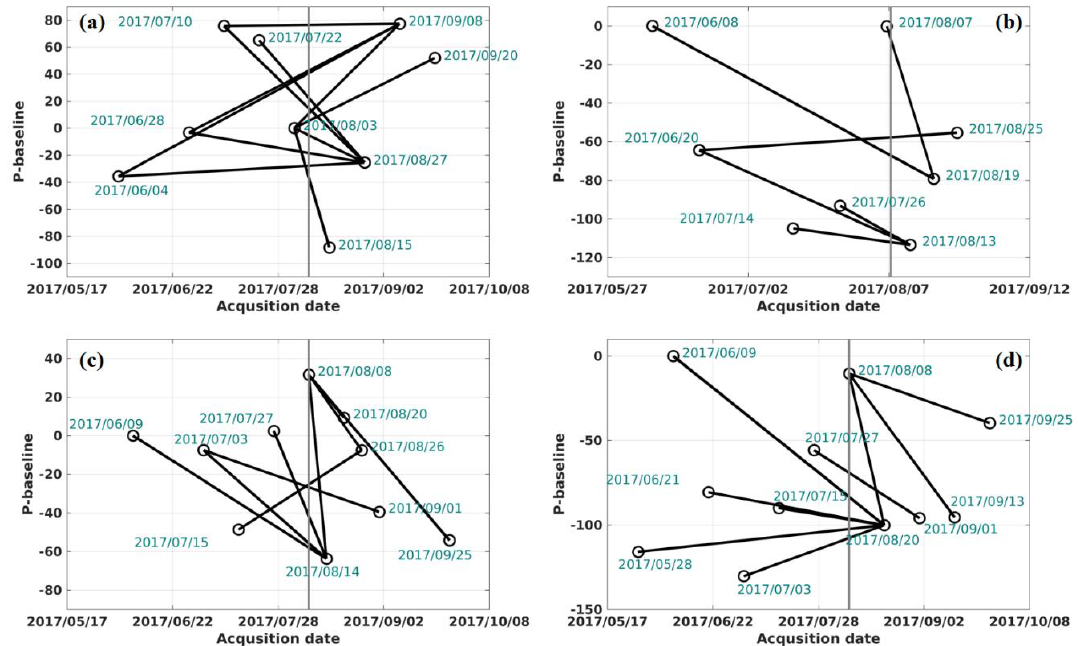
Figure 3. Baseline information for four tracks with different viewing geometries; the y-axis denotes the B ⊥ (P-baseline); and x-axis denotes the acquisition dates formatted as yyyy / mm / dd; the gray line denotes the earthquake date. ( a ) T12 ascending orbit; ( b ) T63 descending orbit; ( c ) T85 ascending orbit; ( d ) T165 descending orbit.